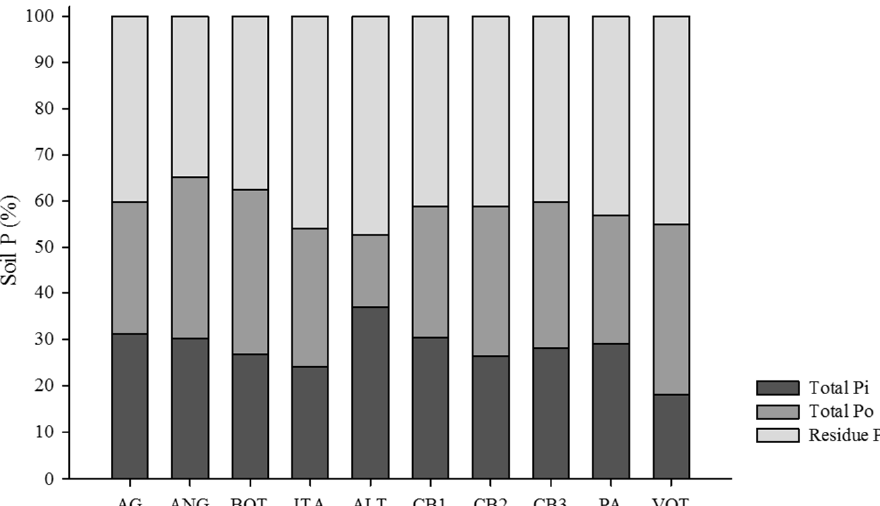
Figure 2. Relative distribution of total organic P, total inorganic P and residue P fractions of total P in soils under Brazilian Eucalyptus plantations. Sites: AG—Agudos, ANG—Angatuba, BOT—Botucatu, ITA—Itatinga, ALT—Altinópolis, CB1—Capão Bonito 1, CB2—Capão Bonito 2, CB3—Capão Bonito 3, PA—Paraibuna, VOT—Votorantim.